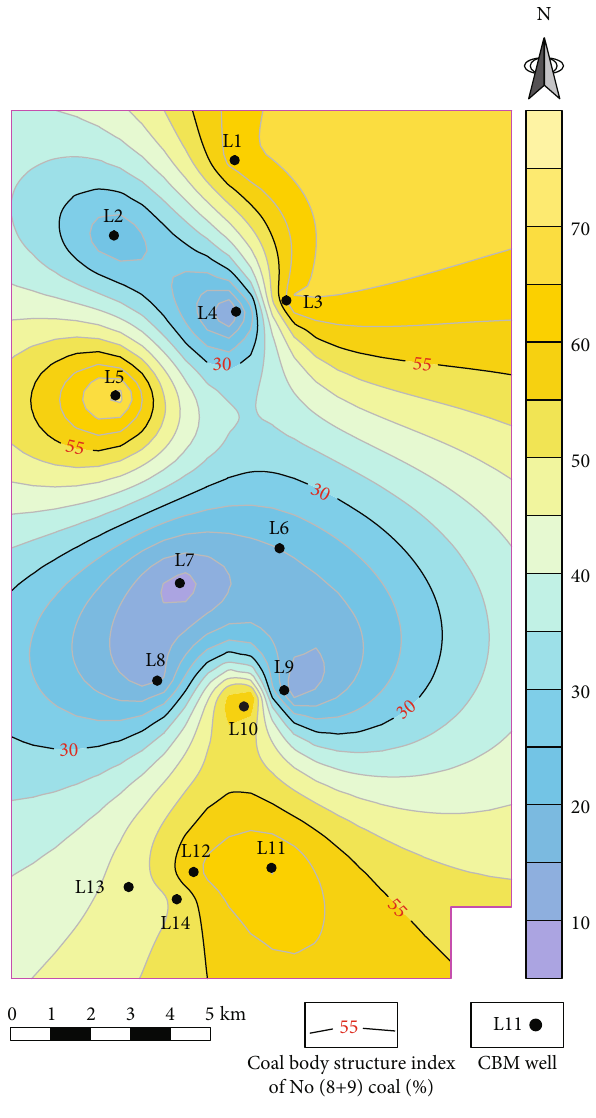
Figure 10: Contour map of coal body structure coal index of No. ( 8 + 9 ) coal in Yangjiapo